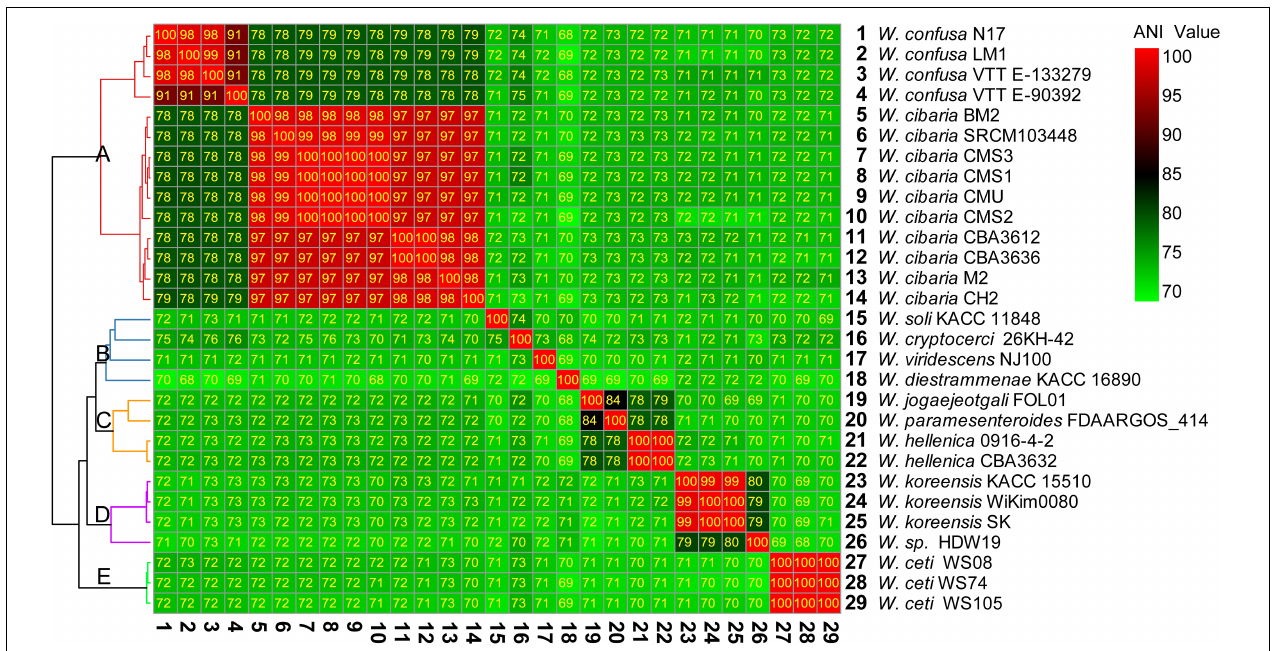
FIGURE 2 | Heatmap of percentage average nucleotide identity (ANI) value between the different species and strains of Weissella . The strain on the vertical axis serves as the